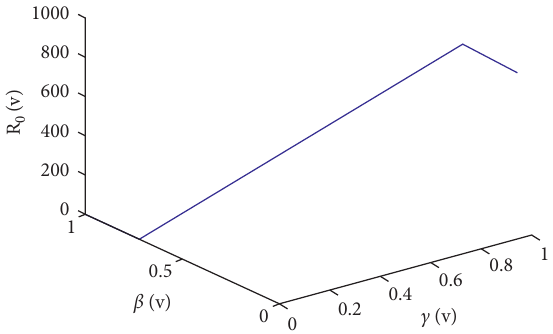
Figure 4: Variation of R